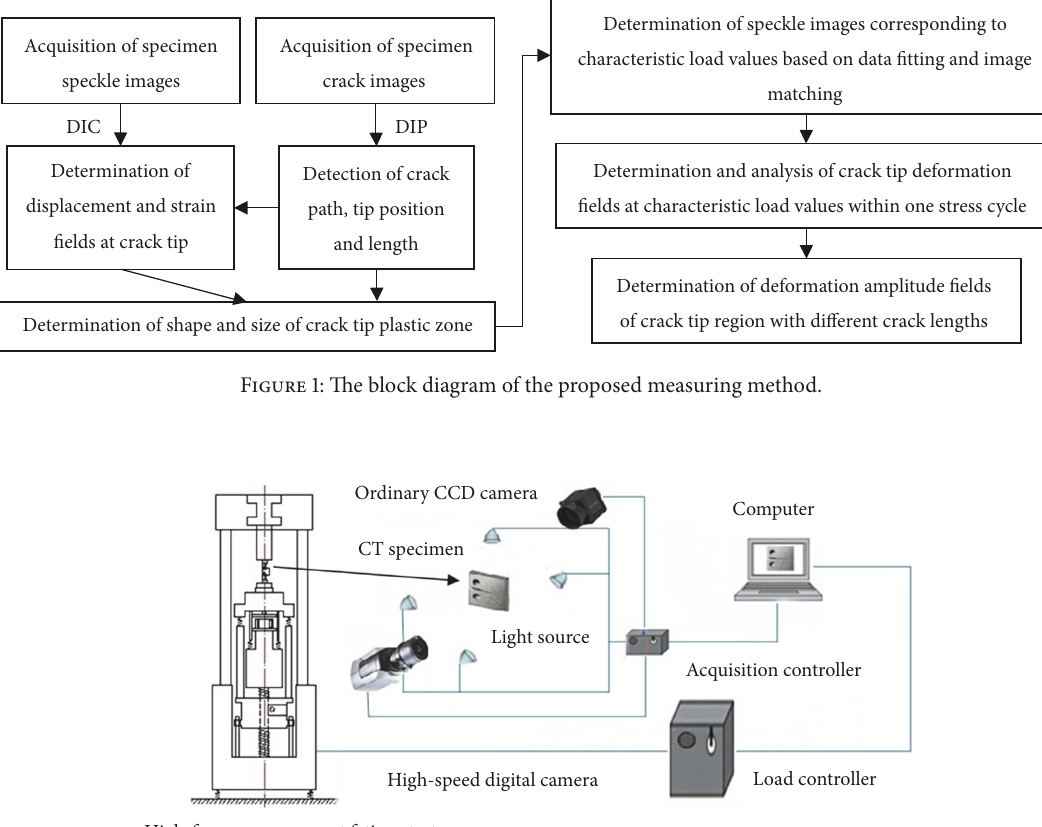
Figure 2: The proposed measuring system of crack tip deformation fields under high-frequency resonant loading.